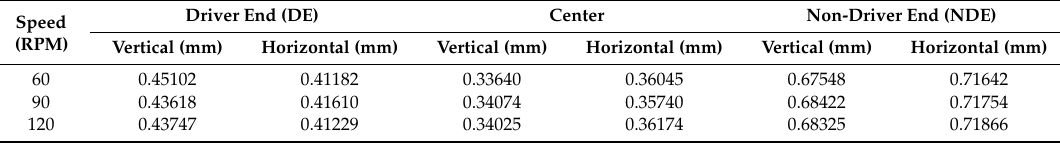
Table 5. The movement of the coil at di ff erent positions in the vertical and horizontal